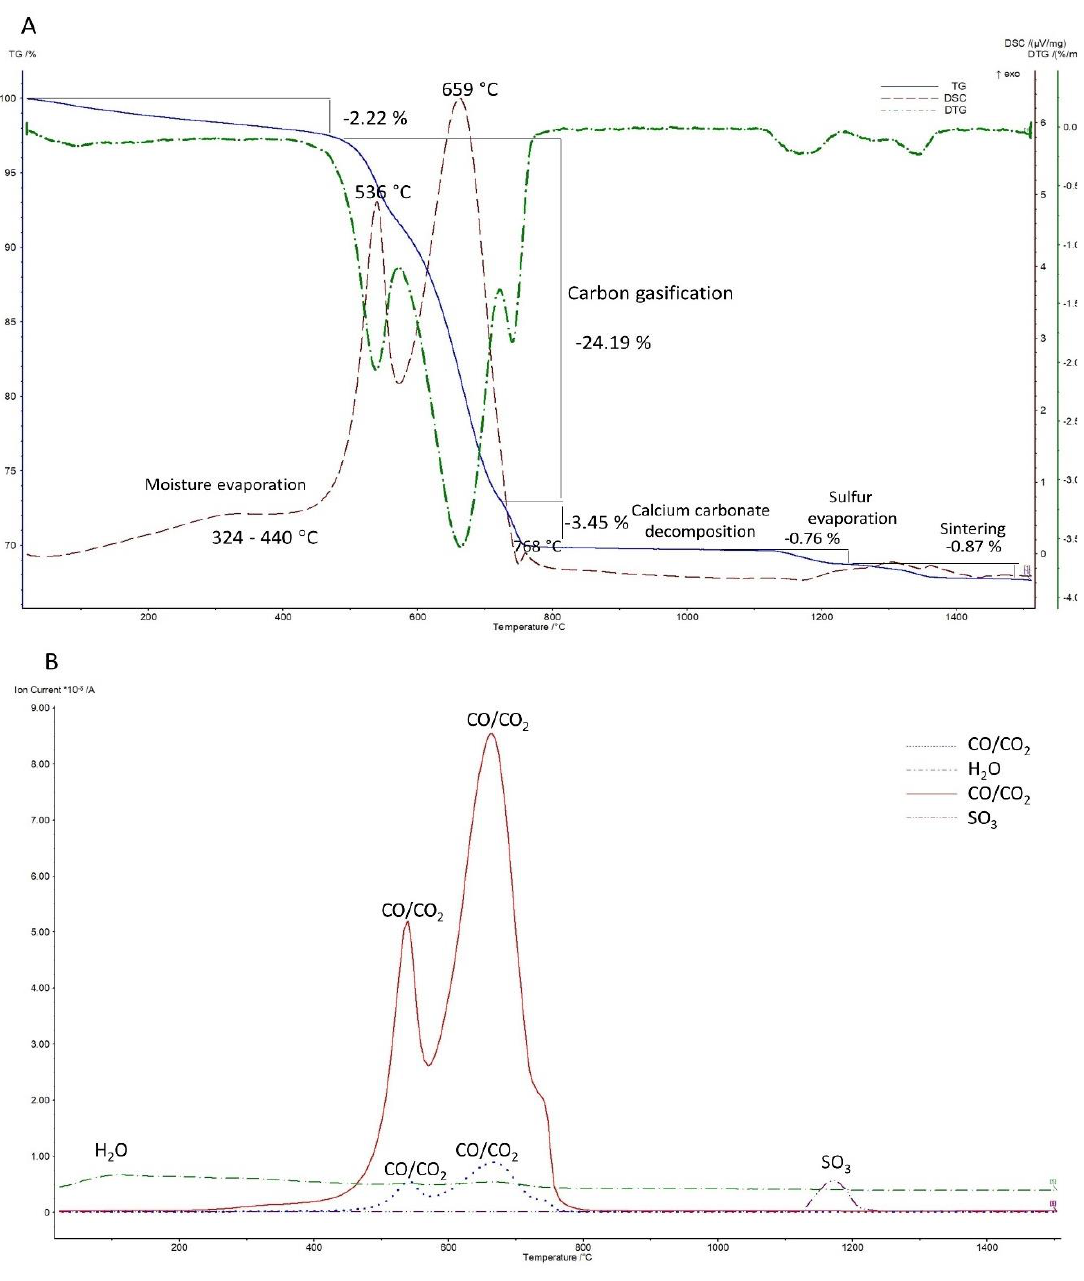
Figure2. ThermalanalysisofBFsludgeunderairatmosphere: ( A )TG / DTA / DTG;( B Figure 2. Thermal analysis of BF sludge under air atmosphere: ( A ) TG/DTA/DTG; ( B ) Mass spectroscopy.